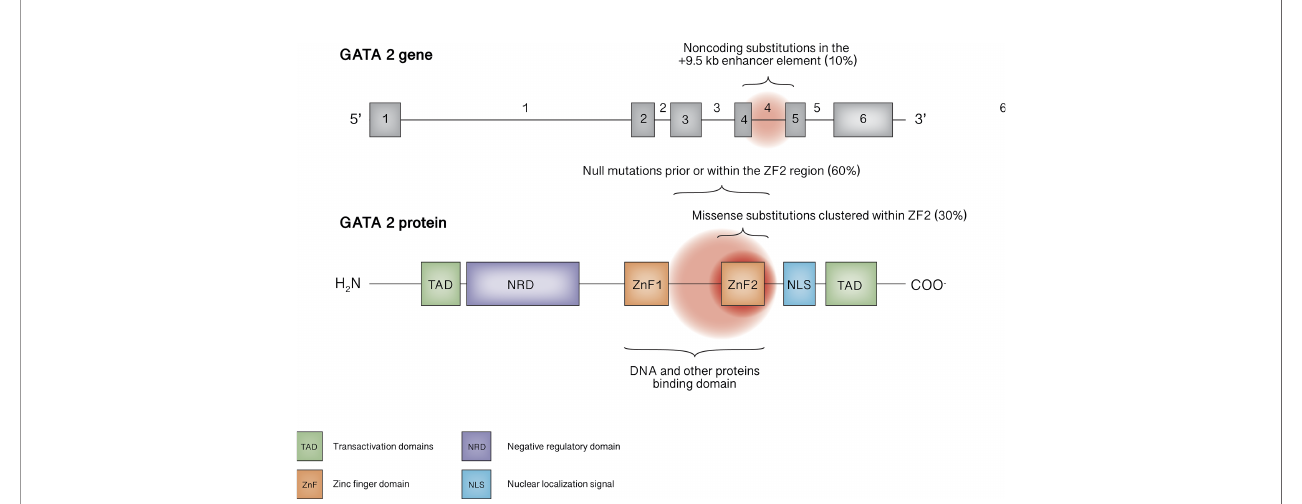
FIGURE 1 | GATA2 gene and protein structure. The mutational spectrum in GATA2 de fi ciency mainly involves truncating mutations occurring before or within ZF2 or missense mutations within ZF2, as well as noncoding mutations within the +9.5 kb enhancer